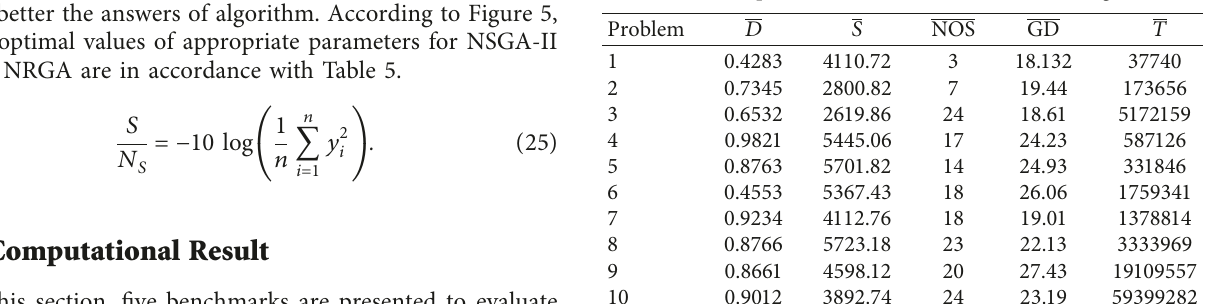
Figure 6: Method to calculate the number of Pareto solutions. Table 6: Comparative criteria value for NSGA-II algorithm.